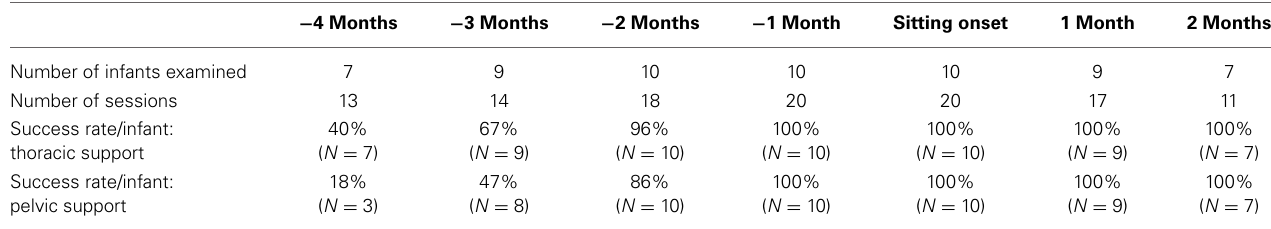
Table 2 | Summary of trial data across